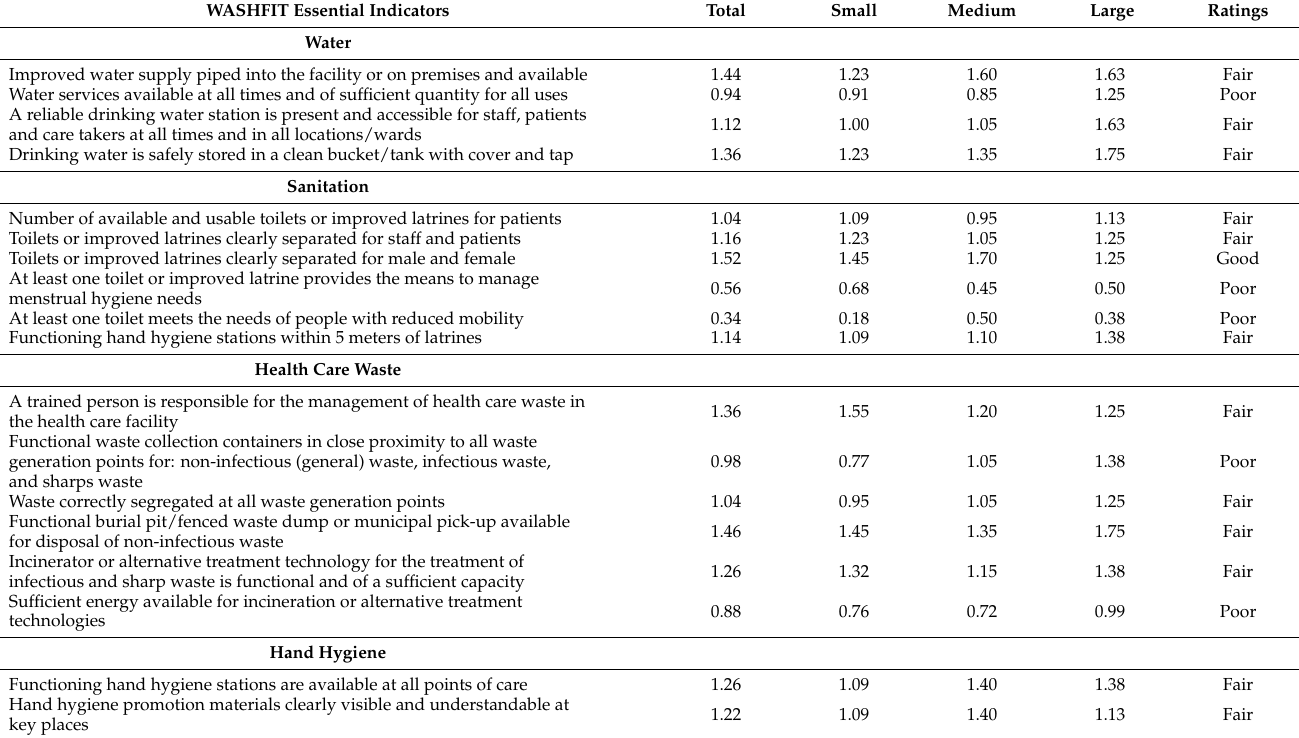
Table 2. WASH FIT assessment results of 50 health care facilities on essential